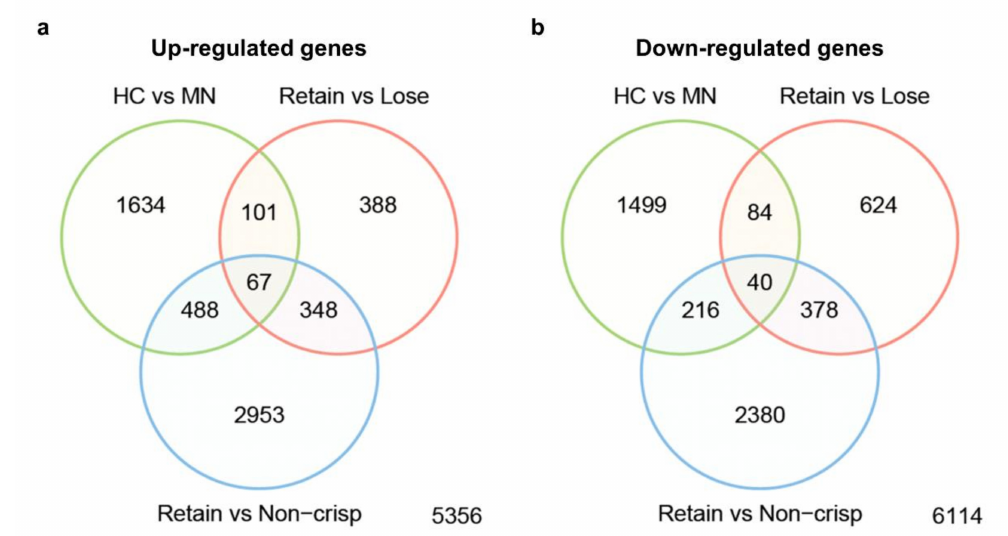
Figure 3. Venn diagram showing the numbers of di ff erentially expressed genes (DEGs) commonly identified between the three comparisons. ( a ) Up-regulated gene = DEGs highly expressed in ’Honeycrisp’ (HC) and “Retain” group, and ( b ) down-regulated genes = DEGs highly expressed in MN1764 (MN), “Lose”, and “Non-crisp”